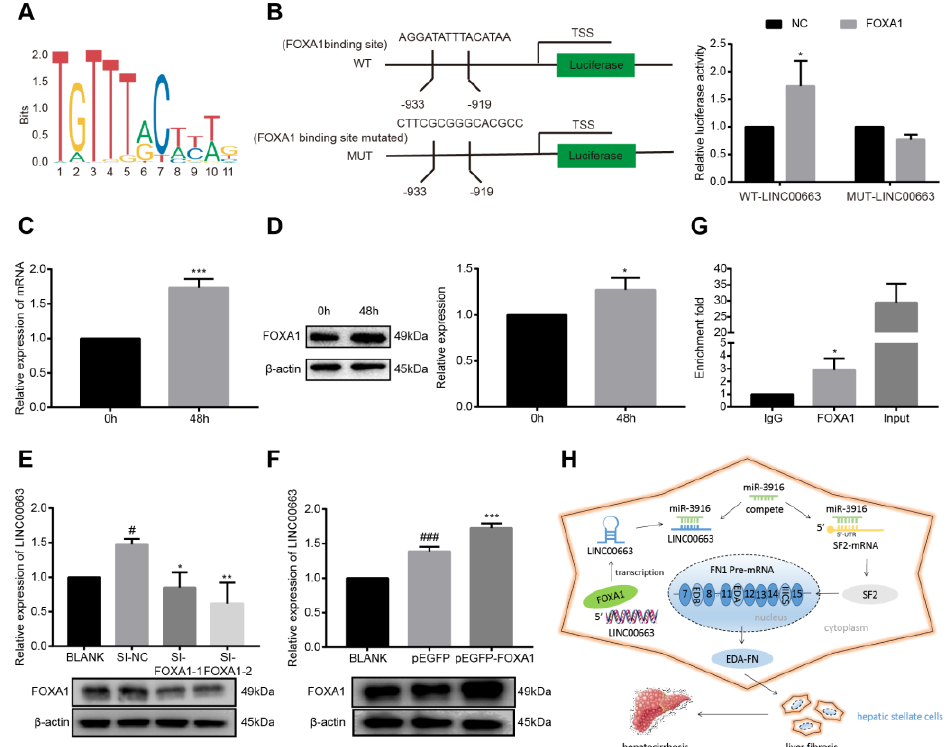
Figure 8. LINC00663 was regulated by FOXA1 transcription factor. ( A ) Bioinformatics predicted binding sites between FOXA1 and LINC00663. ( B ) A schematic diagram shows sequences of wild-type and mutant LINC00663 with FOXA1. A dual-luciferase reporter gene assay was per- formed to identify the interaction between LINC00663 and FOXA1. FOXA1 was upregulated in activated LX-2 cells as detected by ( C ) RT-qPCR and ( D ) WB. Relative expression of LINC00663 in LX-2 cells transfected with ( E ) si-FOXA1 and ( F ) pEGFP-FOXA1 detected by RT-qPCR. ( G ) ChIP experiment with FOXA1, IgG as negative control, and input as a positive control from LX-2 cell extracts using RT-qPCR. ( H ) Schematic representation of FOXA1/LINC00663/hsa-miR-3916/SF2-FN regulatory axis. * p < 0.05, ** p < 0.01, *** p < 0.001. # p < 0.05, ### p < 0.001. * vs. NC, # vs. BLANK. Each experiment was repeated three times and similar results were obtained. ChIP, chromatin immunoprecipitation; FN, fibronectin; FOXA1, forkhead box A1; HSCs, hepatic stellate cells; RT-qPCR, real-time quantitative PCR; SF2, splicing factor 2; siRNA, small interfering RNA; WB, western blot. 4. Discussion In recent years, with the widespread recognition of cholestatic liver fibrosis and the gradual increased use of serum anti-mitochondrial antibody, the incidence of PBC and PSC has shown a rapid upward trend. The incidence of PBC in China increased from 2.16/100,000 in 1991 to 2000 to 8.99/100,000 in 2011 – 2020; PBC cases have increased worldwide [32]. At present, epidemiological data on PSC in China is lacking, but data from Northern Europe and North America have shown that the incidence of PBC has been steadily increasing year after year [33].